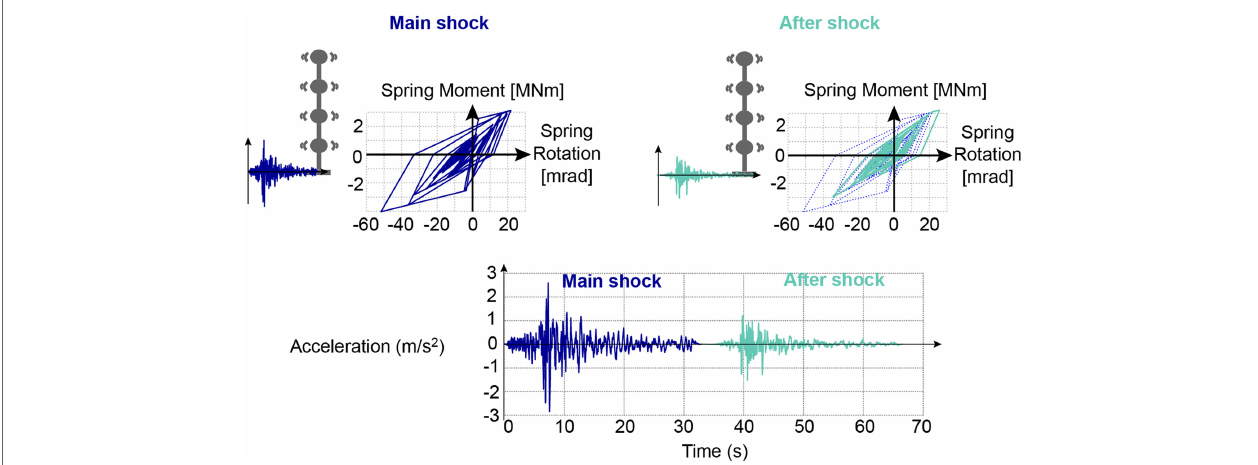
initial frequencies, initial MAC values, post-earthquake frequen- cies, and post-earthquake MAC values. Model uncertainty dis- tributions are obtained as a uniform distribution between the minimum and the maximum error calculated for the three first modes that are used for identification. Likelihood functions for TBMU and MBMU that are derived from combining predefined measurement and model uncertainties based on Eq. 10 for nat- ural frequencies before and after the main shock are shown in Figure 4 . Falsification thresholds that are used in EDMF are equivalent to the boundaries of the MBMU. The uncertainty distribution that is calculated using the true model is not zero- mean. Thus, a zero-mean normal distribution that is fitted using such a biased distribution results in a wider distribution when compared to the uniform likelihood function related to MBMU (see Figure 4 ). Three vibration modes are used for identification. There- fore, in order to limit the number of uncertainty distributions, single distributions are calculated for initial natural frequen- cies, post-earthquake natural frequencies, initial mode-shapes, and post-earthquake mode-shapes. Therefore, when uncertain- ties are parametrized for BMU applications, additional param- eters need to be identified. For TBMU, SD for four indepen- dent zero-mean normal distributions are identified (S 3,TBMU in Table 2 ). For MBMU, eight additional uncertainty parame- ters are identified, being the mean and SD of uniform likeli- hood functions (S 3,MBMU in Table 2 ). For numerical stability reasons, uniform likelihood functions are approximated with generalized Gaussian distributions with a norm ( κ ) of 250 (see Eq.